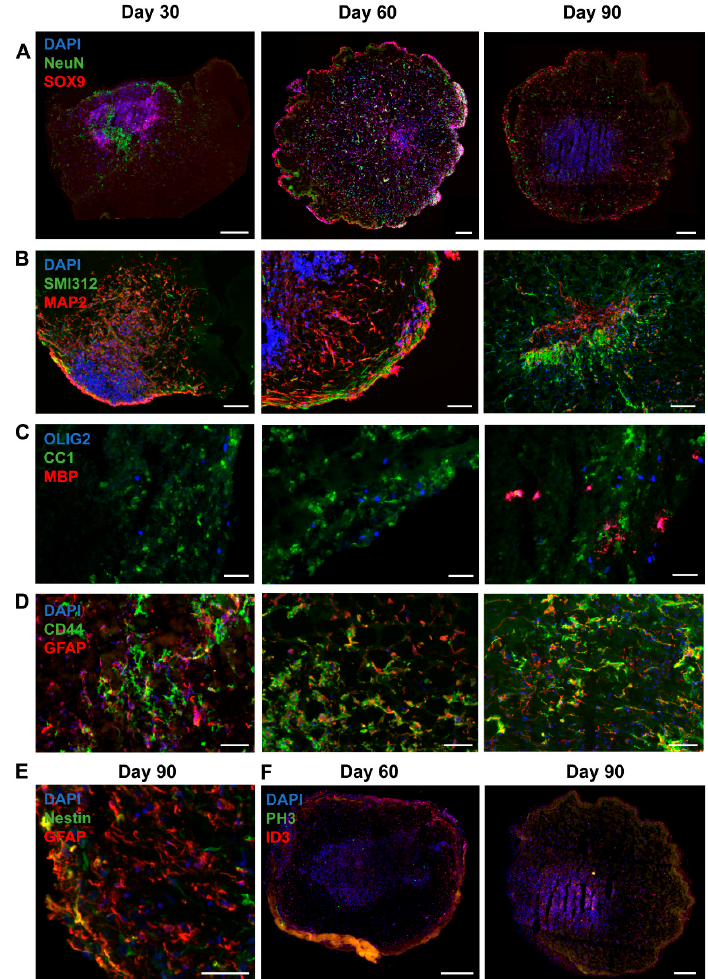
Figure 6. Organoids contain a mix of neural cell populations . Immunostainings at different time points show that a mix of neural cell populations develop in organoids. The presence of neurons is shown by staining for NeuN ( A ), dendritic marker MAP2 and axonal marker SMI312 ( B ). Oligodendrocyte progenitor cells (OLIG2 + ) and oligodendrocytes (CC1 + ) are present at day 30 and day 60, while mature MBP + oligodendrocytes are only observed at day 90 ( C ). Astrocytes were present from day 30 onwards, as shown by staining for SOX9 ( A ), GFAP, CD44 ( D ), Nestin ( E ) and ID3 ( F ). PH3 staining shows proliferating cells in day 60 and day 90 organoids ( F ). ( A , F ) Scalebar = 200 μ m. ( B ) Scalebar = 100 μ m. ( C – E ) Scalebar = 50 μ m.